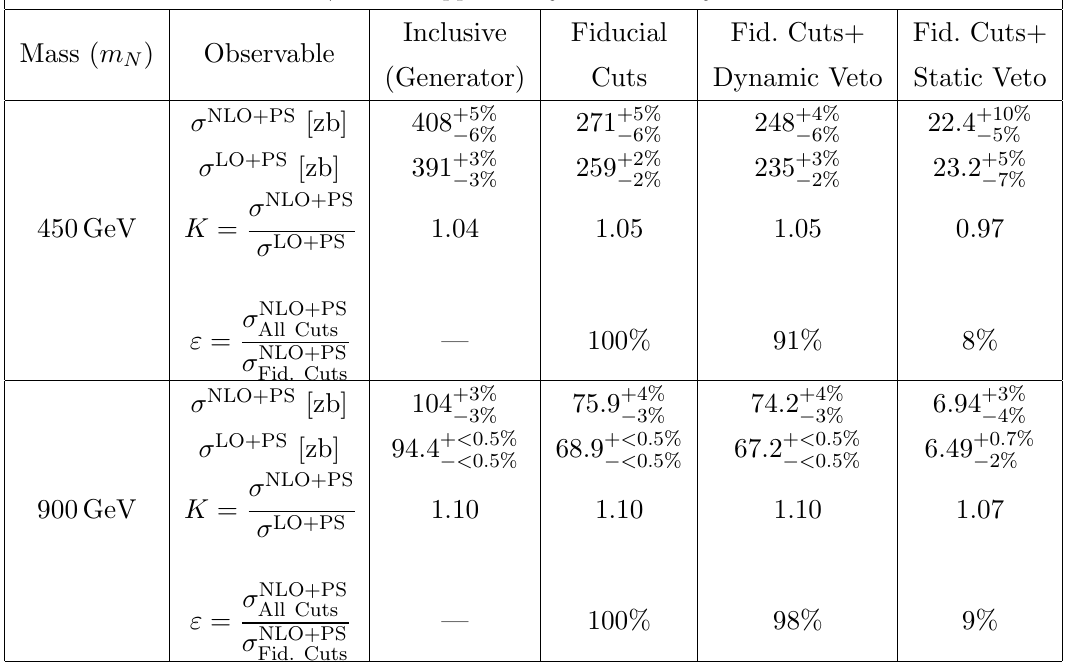
N‘j + X 3 ‘(cid:23)j + X signal ! !